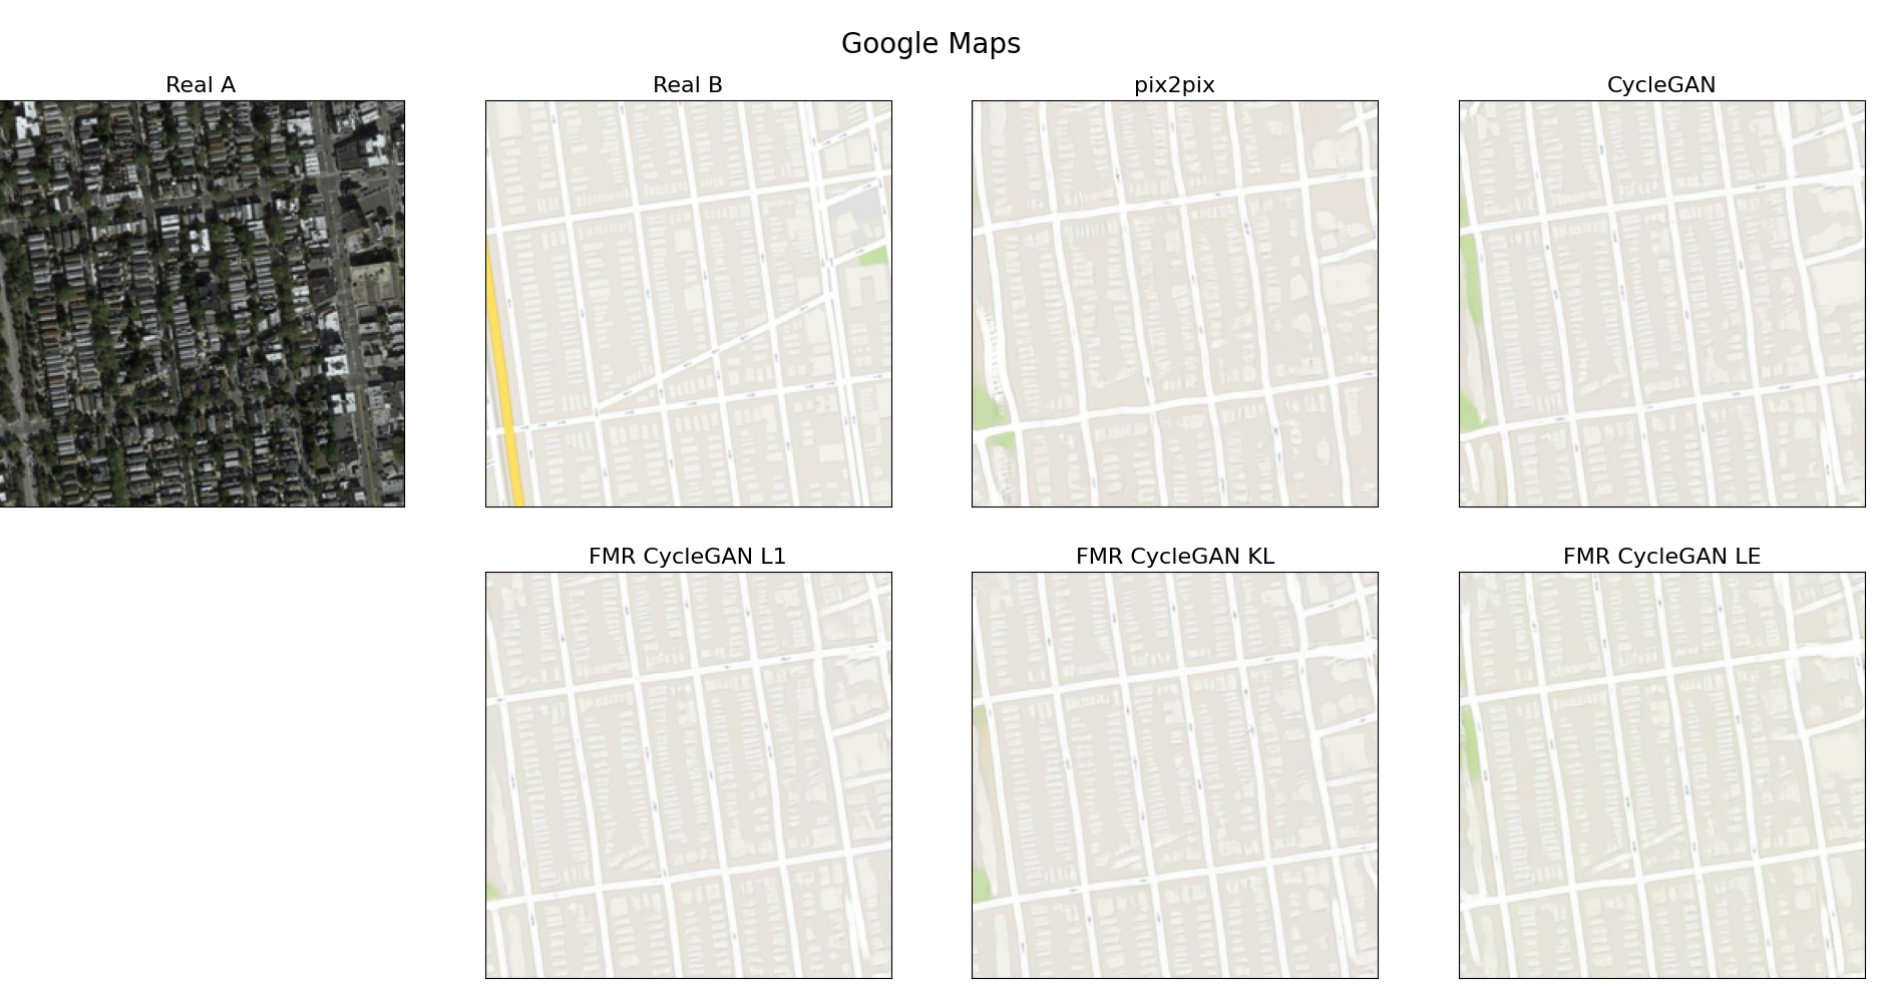
Figure 3. Visual comparison on the second example of paired images from the Google Maps aerial2map task (denoted as “Real A”, belonging to the source or “left” domain, and “Real B”, belonging to the target or “right” domain). The Proposed FMR CycleGAN with various ground distances (L1 corresponding to (8), KL corresponding to (10), and LE corresponding to (12)) was compared against the baseline CycleGAN and pix2pix